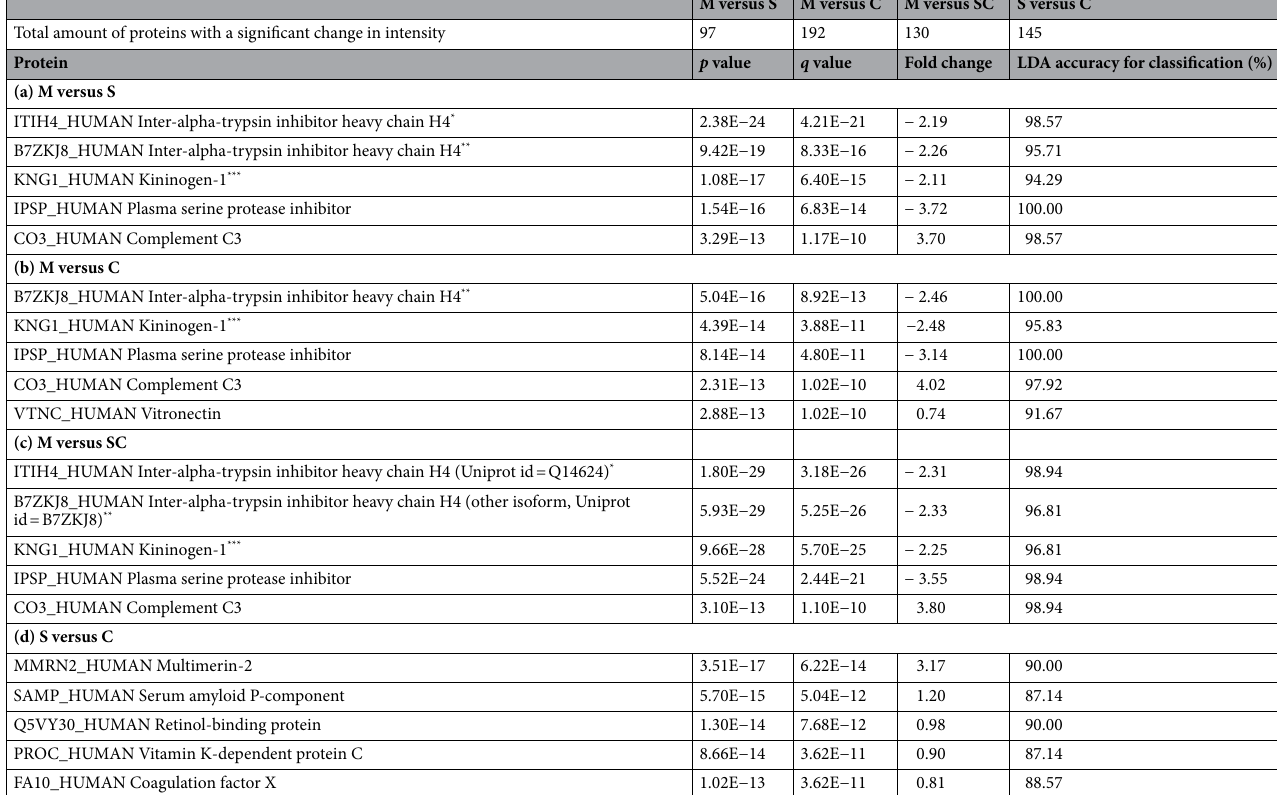
Table 2. The number of proteins with significantly changed intensities between the selected two groups. The number of proteins with a significant change in protein intensity quantification values between the selected two groups, followed by five proteins with the most significant change according to the t-test p value from each comparison (a) M versus S, (b) M versus C, (c) M versus SC, (d) S versus C. The p value = p value of the Student’s t-test for the intensity quantification values of selected proteins; q value = t-test p value after the multiple comparison test correction by the Benjamini–Hochberg procedure. Fold change = binary logarithm of the ratio of mean protein intensity quantification value of tested groups. LDA accuracy for classification = linear discriminant analysis of the intensities of selected proteins using a leave-one-out cross-validation scheme to estimate the accuracy. * MaxQuant search id 762. ** MaxQuant search id 1000, *** MaxQuant search id 181.